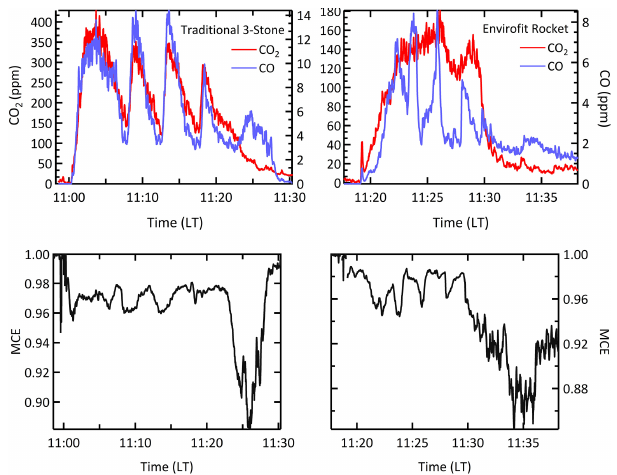
Figure 9. Excess mixing ratio profiles of CO and CO 2 for both a traditional three-stone cooking fire (104) and a more advanced “rocket” design stove (115) showing cleaner combustion and shorter time to reach a steady state in the stove. The profiles of MCE vs. time are included for both stove types.